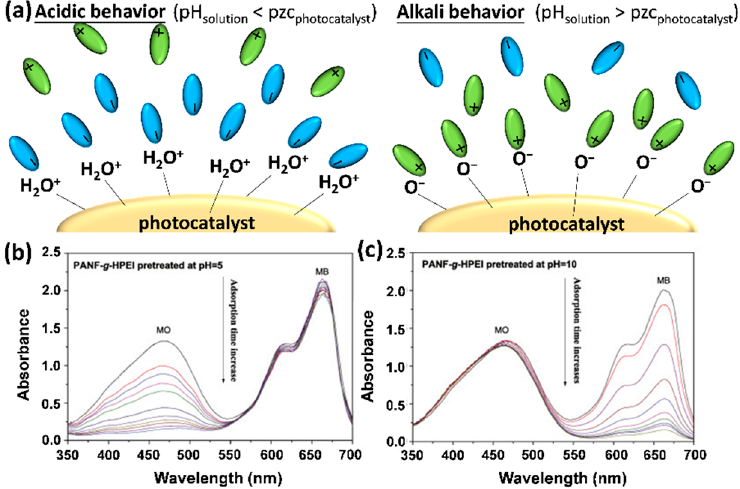
Figure 5. ( a ) Model of the absorption of cationic and anionic dye molecules on the photocatalyst surface under acidic and alkali conditions. Evolution of UV–visible absorption spectra of MO/MB mixed solution in the presence of PANF-g-HPEIs pre-treated at ( b ) pH = 5 and ( c ) pH = 10 (reproduced with permission from [62] . Copyright Elsevier Science Publishers, 2015.).